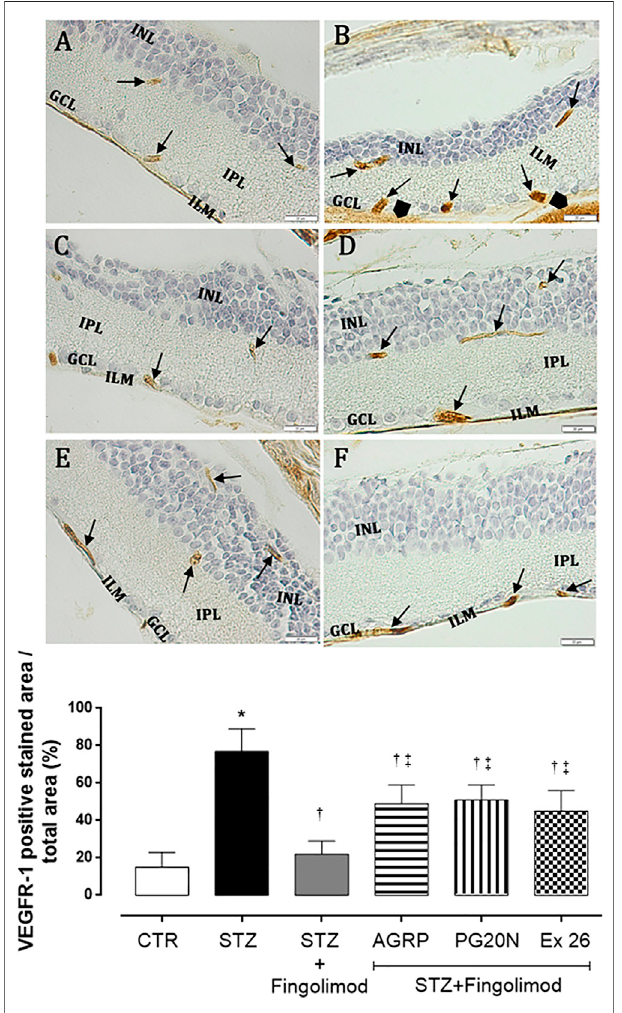
FIGURE3| VEGFR1 immunohistochemistryintheretinaofnon-diabetic mice [panel (A) , CTR], diabetic mice [panel (B) STZ], diabetic mice receiving Fingolimod alone [panel (C) , STZ + Fingolimod], or in combination with MC1R antagonist [panel (D) , STZ + Fingolimod + AGRP], MC5R antagonist [panel (E) ,STZ+Fingolimod+PG20N],andSP1R1antagonist[panel (F) ,STZ + Fingolimod + Ex 26]. VEGFR1 positive stain (arrow). VEGFR1 protein levels are reported as percentage (%) ± standard deviation (S.D.) of positive stained area/total area. The images are representative of 10 histological observations pergroup.Statisticalsigni fi cancewasassessedbyone-wayANOVA,followed byTukey ’ smultiplecomparisontest. * p < 0.05vsCTR; † p < 0.05vsSTZ; ‡ p < 0.05 vs STZ + Fingolimod. INL, inner nuclear layer; IPL, inner plexiform layer; ILM, inner limiting membrane; GLC, ganglion cell layer; retinal microvessels staining of VEGFR1 (arrow), non-vascular staining of VEGFR-1 (arrowhead); magni fi cation: 40X; scale bar: 20 µm. N (cid:1) 5 retinas per group. Particularly, the highest VEGFA levels were detected in diabetic retina (102 ± 8 pg/ml; p < 0.01 vs CTR group), while levels were signi fi cantly reduced by fi ngolimod treatment (48 ± 4 pg/ml; p < 0.01 vs STZ) ( Figure 5A ). The combination of fi ngolimod plus MC1R or MC5R antagonists signi fi cantly increased VEGFA levels compared to fi ngolimod alone (78 ± 9 pg/ml and 84 ± 6 pg/ ml, both p < 0.05 vs STZ + Fingolimod), while diabetic mice